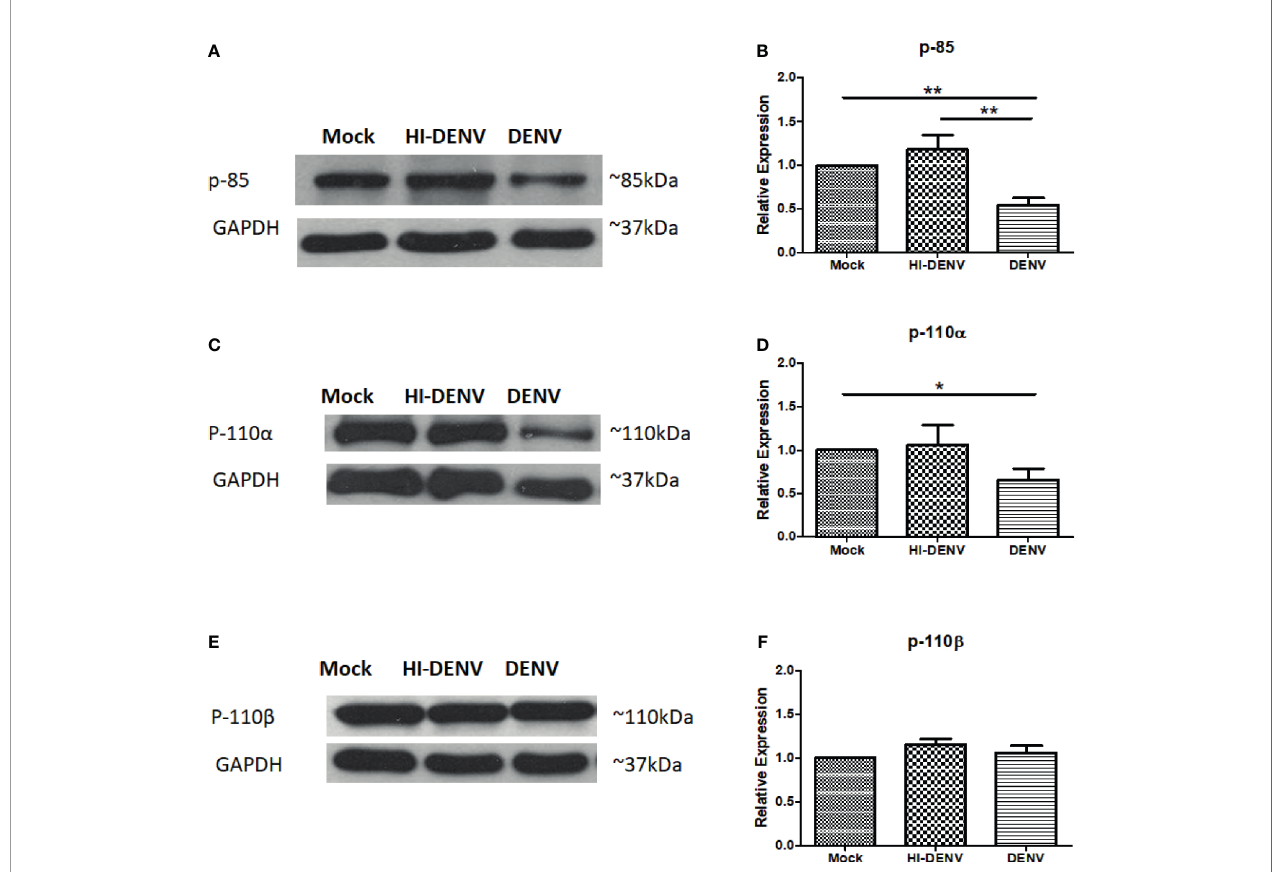
FIGURE 2 | Immunoblotting of PI3K regulatory and catalytic unit proteins. Representative immunoblots and relative expression of (A, B) p-85, (C, D) p110- a , and (E, F) p-110- b in mock-infected, DENV inactivated virus treated, and DENV infected MEG-01 cell lysate. (*pValue < 0.05; **pValue <